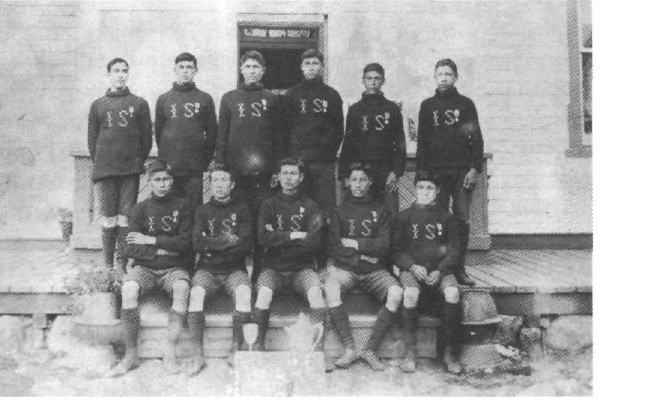
Figure 2. "Battleford Industrial School football team", 1897. Courtesy of Glenbow Museum, Calgary,